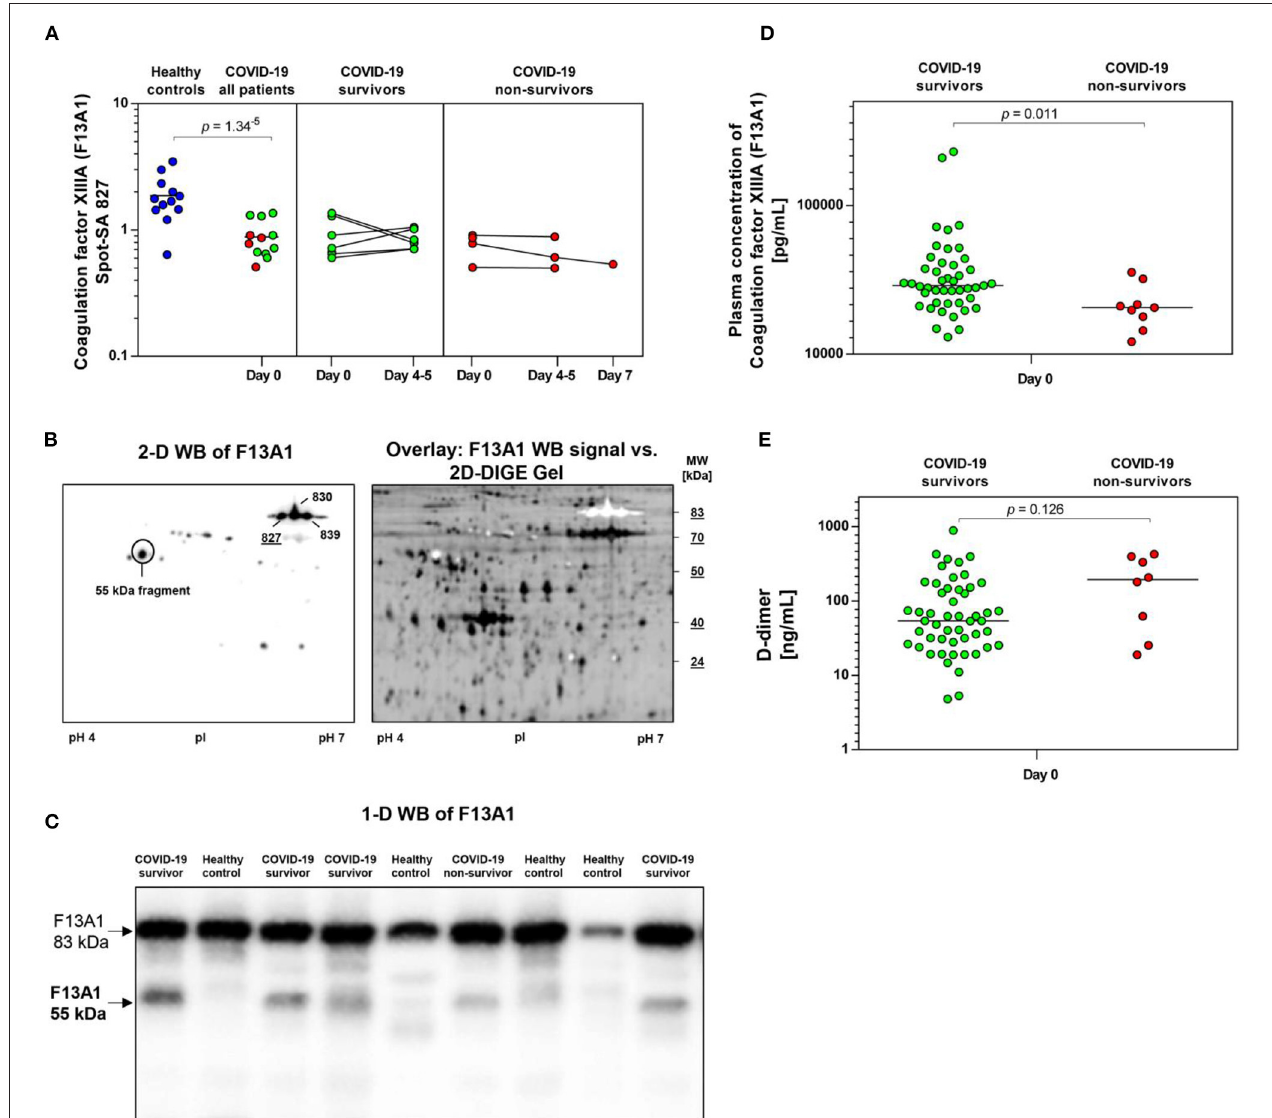
FIGURE 4 | COVID-19-dependent course of the abundance of F13A1 in platelets. (A) Protein levels of F13A1 proteoform (spot 827). Scatter dot plot and time course of COVID-19 patients of F13A1 standardized platelet protein spot abundance quantified by 2D-DIGE. (healthy controls: n = 12; COVID-19 survivors: n = 9; COVID-19 non-survivors: n = 4). (B) Platelet proteins were separated according to their molecular weight (MW) and isoelectric point (pI). 2-D western blot (WB) image of platelet F13A1 probed with monoclonal anti-F13A1 antibody (left). Cy2-labeled protein was applied to IEF on a 24cm pH 4–7 IPG-strip. Overlay of whole protein (black) and F13A1 signal (white) (right). Overlay of 2D-DIGE gel vs. F13A1 WB-signal, obtained through the Online Image Editor (https://www.online-image-editor.com). (C) Representative 1-D WB image of F13A1 in platelet proteins from COVID-19 survivors ( n = 4), COVID-19 non-survivors ( n = 1) and healthy controls ( n = 4). The anti-F13A1 antibody detects two protein bands with molecular weight of 83 and 55 kDa. (D) Plasma F13A1 concentration at day 0 (COVID-19 survivors: n = 45; COVID-19 non-survivors: n = 8). (E) Plasma levels of D-dimer at day 0 (COVID-19 survivors: n = 45; COVID-19 non-survivors: n = 8). Protein levels of F13A1 and D-dimer were depicted as single values and mean. 2D-DIGE, two-dimensional differential in-gel electrophoresis; kDa, kilodalton.